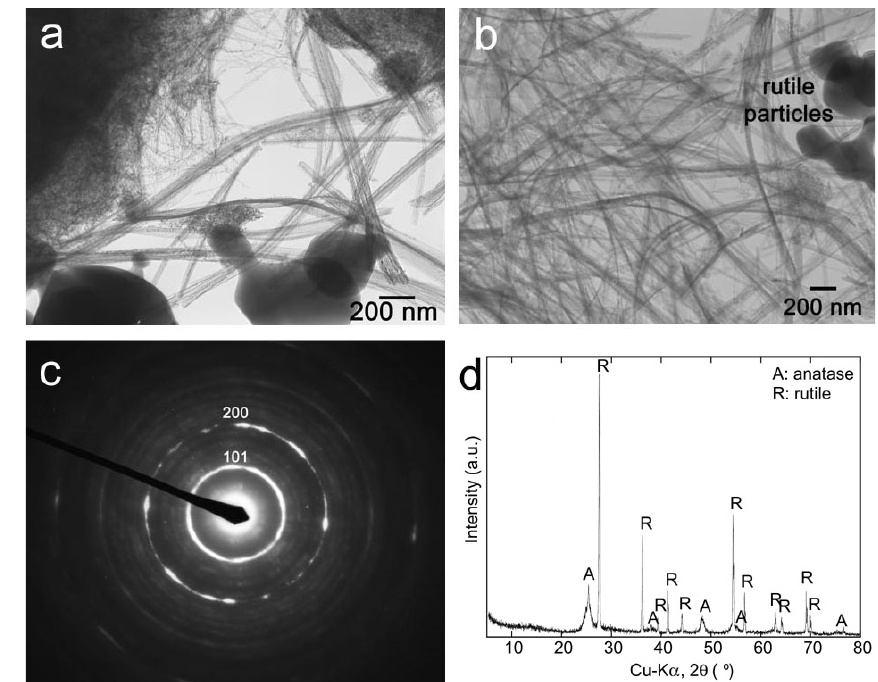
Fig. 3 (a,b) TEM micrographs, showing the co-existence of fine nanowires, nanowire- coated rutile and rutile particles (c) SAED pattern for the nanowire area of the partially nanowire-structured TiO (showing anatase pattern), and (d) XRD pattern for the whole 2 partially-nanowire structured TiO 2